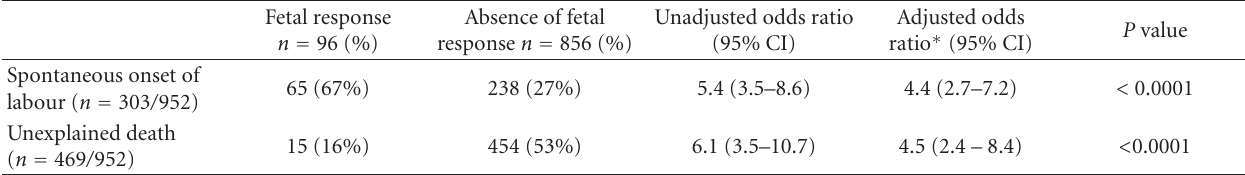
Table 2: Relationship of fetal response to spontaneous onset of labour and unexplained fetal death.